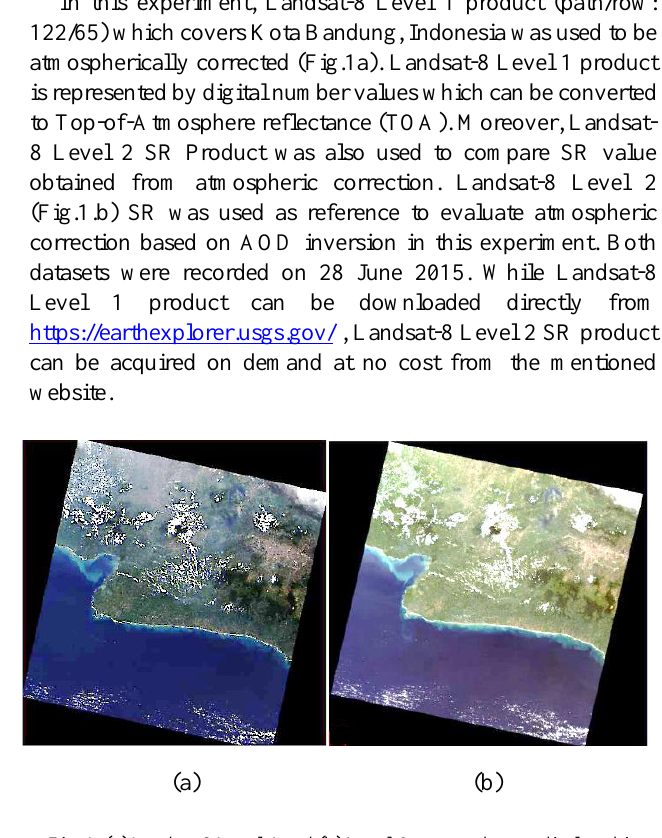
Fig. 1. (a) Landsat-8 Level-1 and (b) Level-2 over study area displayed in natural colour.